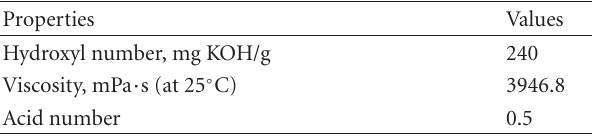
Table 3: Specifications of soy-phosphate polyol